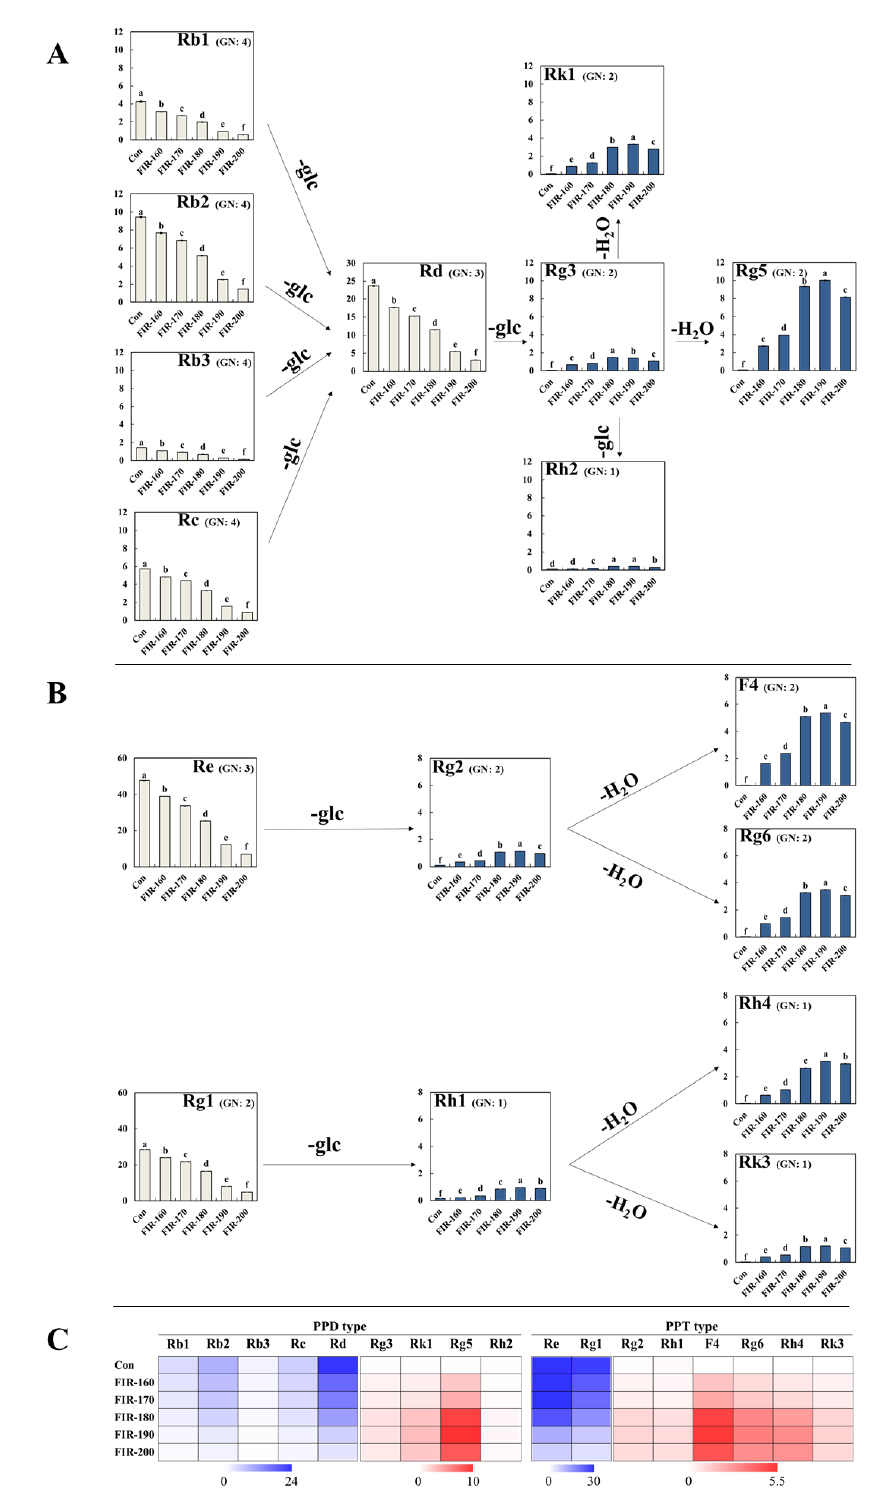
Figure 3. Flow schemes of the conversion patterns of PPD type ( A ) and PPT type ( B ) of ginsenosides in ginseng leaves treated by FIR at different temperatures. A heat map ( C ) of 17 kinds of ginsenoside changes in ginseng leaves treated by FIR at different temperatures. The unit of ginsenoside content is mg/g dry weight. GN indicates the glycosyl number attached on ginsenoisde. The values in bar graphs are expressed as the mean with standard error ( n = 3). Different letters (a–f) above the bar graphs indicate significant differences at p < 0.05 on Tukey’s HSD